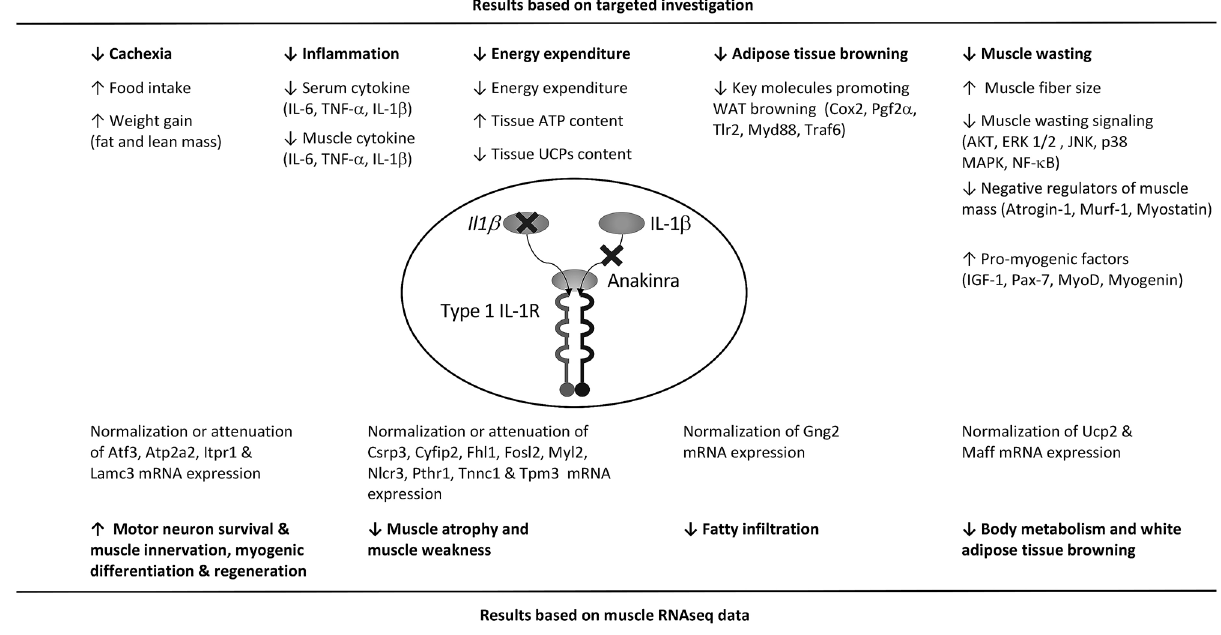
Figure 9. Summary of the beneficial effects of anakinra on cachexia, energy homeostasis, muscle wasting and adipose tissue browning in CKD